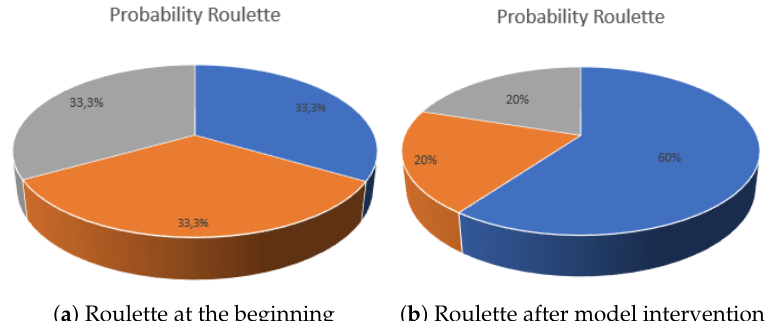
Figure 3. Graphic example of the modification of probabilities by the